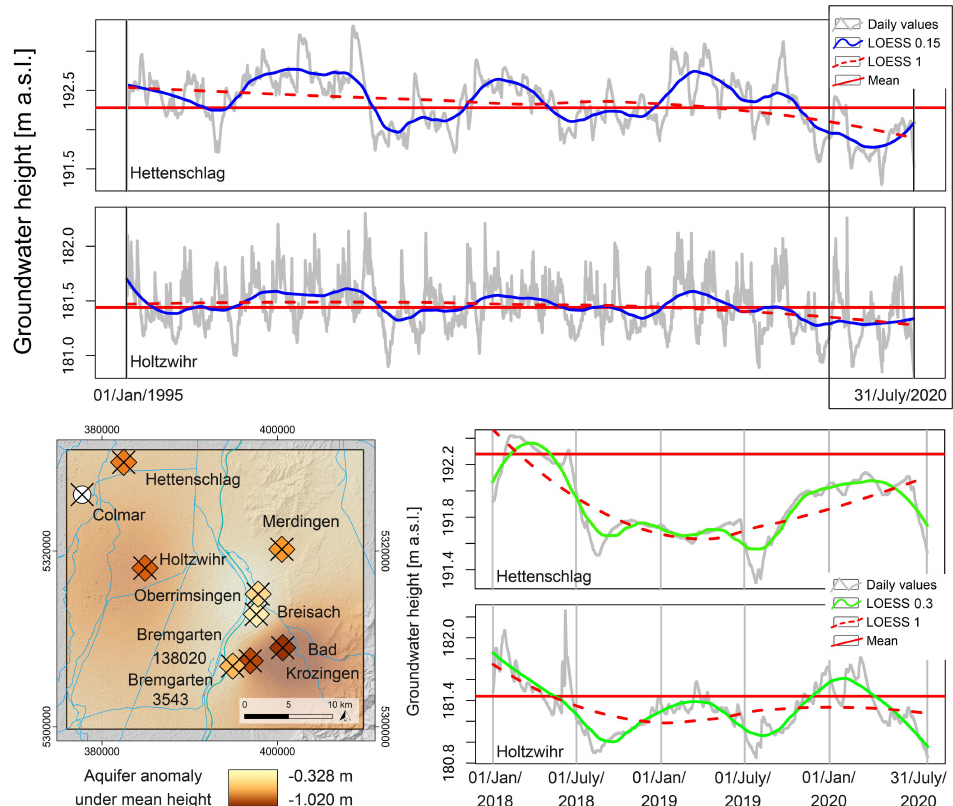
Figure 9. Groundwater fluctuations in the Upper Rhine Area modeled for two piezometer stations in the Alsace (Holtzwihr, Hettenschlag) over the measurement series 1 January 1995–31 July 2020. The daily measurements (grey line) were smoothed using R software and a local regression scatterplot smoothing algorithm (LOESS) with the parameters 0.15 (blue line), 1 (dashed red line), and 0.3 (green line). The period 1 January 2018–31 July 2020 is displayed in detail to visualize the current trend in groundwater level decrease during the subsequent drought years 2018, 2019, and 2020 in the study area. Mean values for both stations indicate the general trend in groundwater lowering in the URA (red line is the mean value; the dashed red line is the long-term trend). The map shows the distribution of the measurement stations in the case study area. Colmar has the lowest precipitation record in the URA (550 mm /